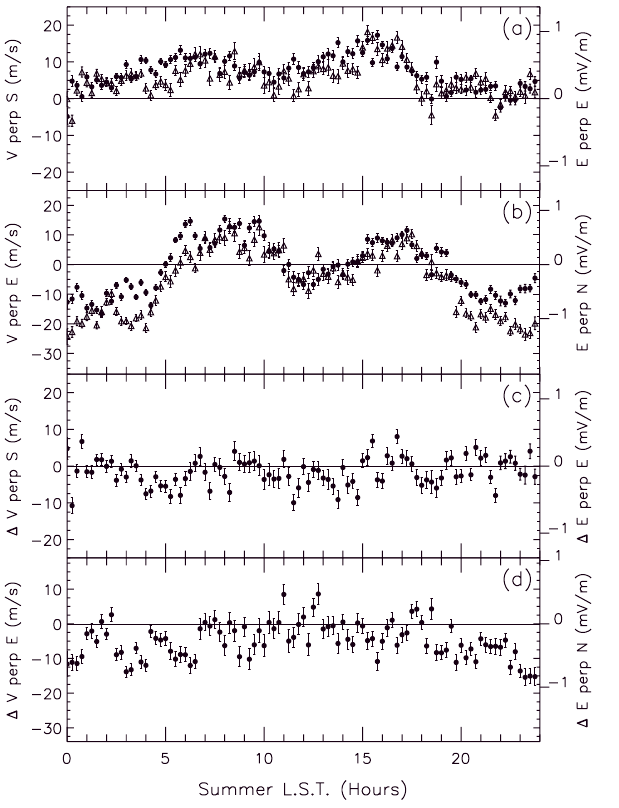
Fig. 4. The same results as Fig. 3 except for